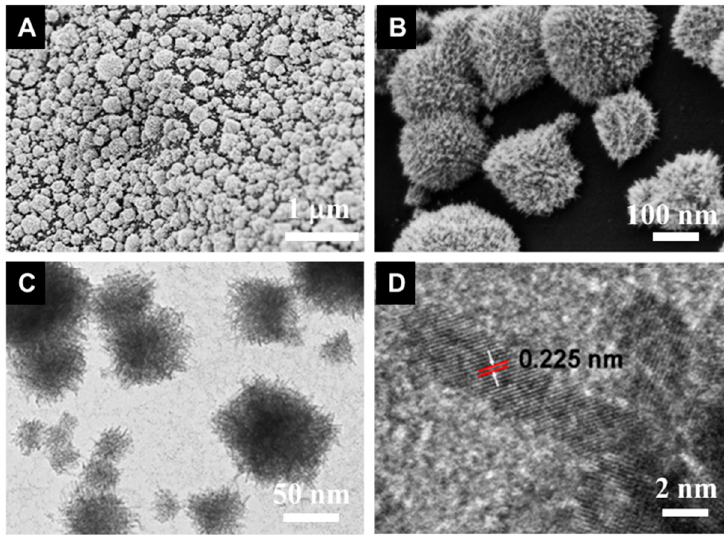
Figure 4. ( A ) SEM micrograph of formed PtNFs/3D graphene. ( B ) Magnified SEM micrograph of